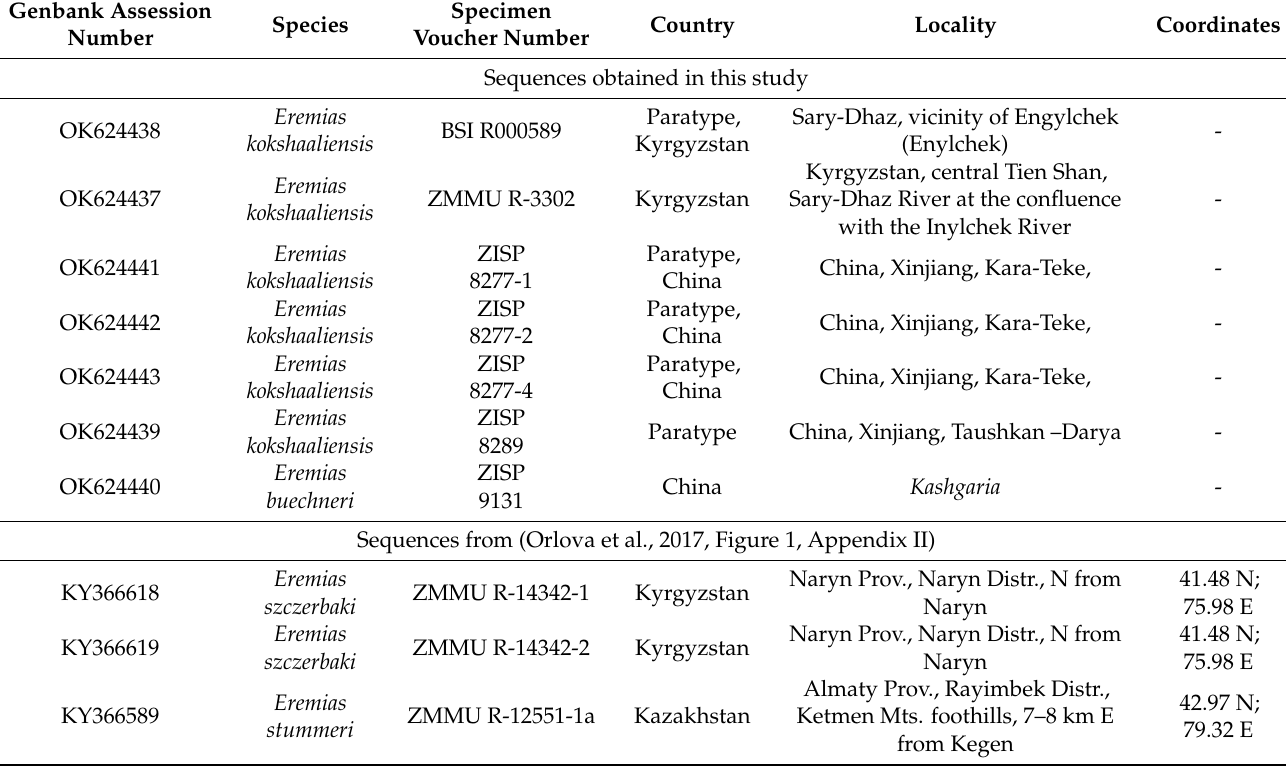
Table 1. Samples used in molecular